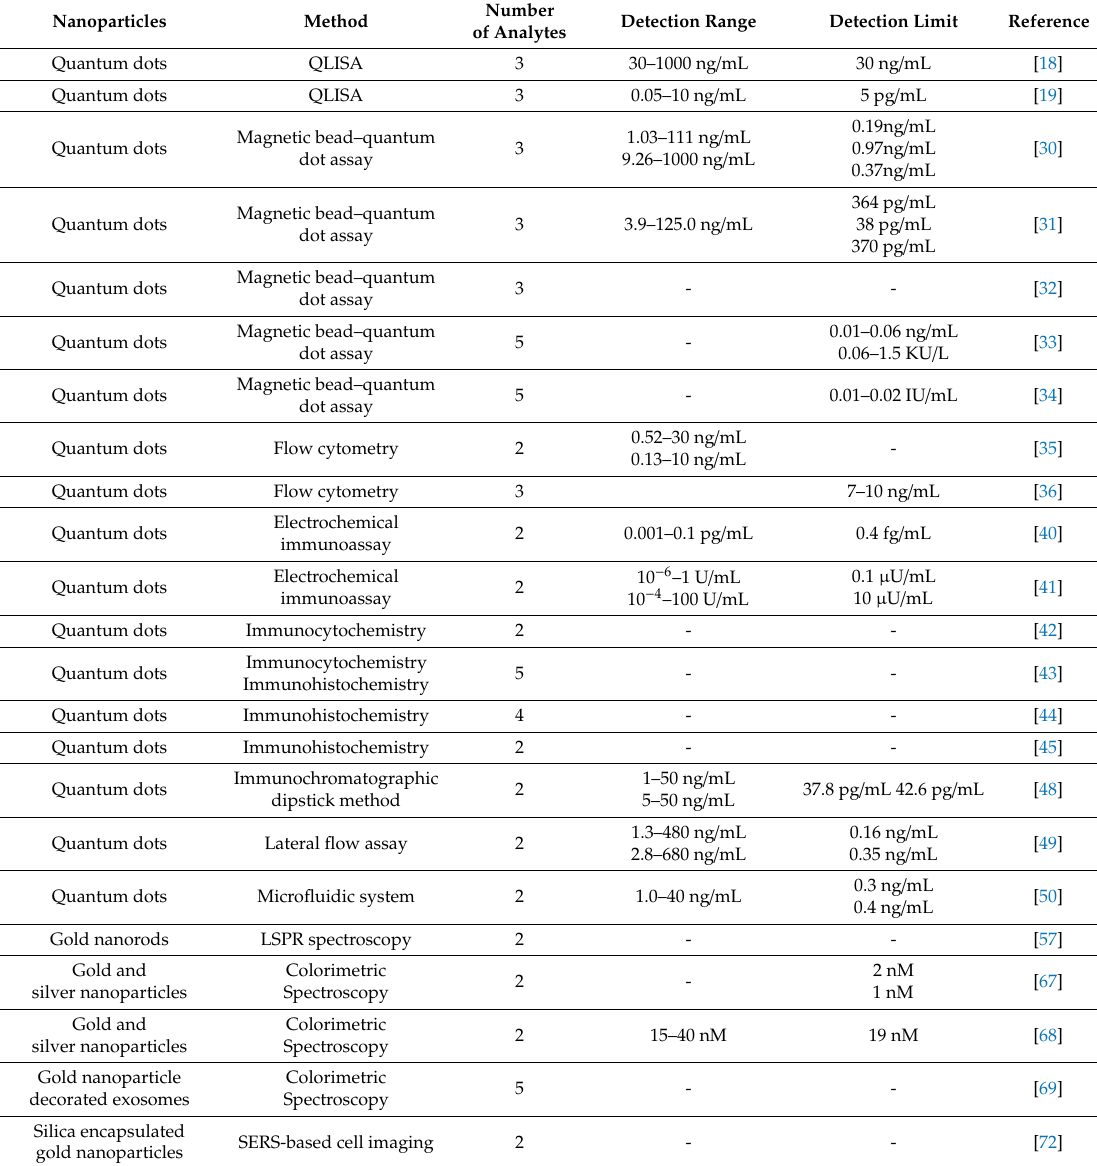
Table 1. Summary of described multiplexing nanobiosensors: used nanoparticles, method of detection, number of detected analytes, detection range and detection limit (if